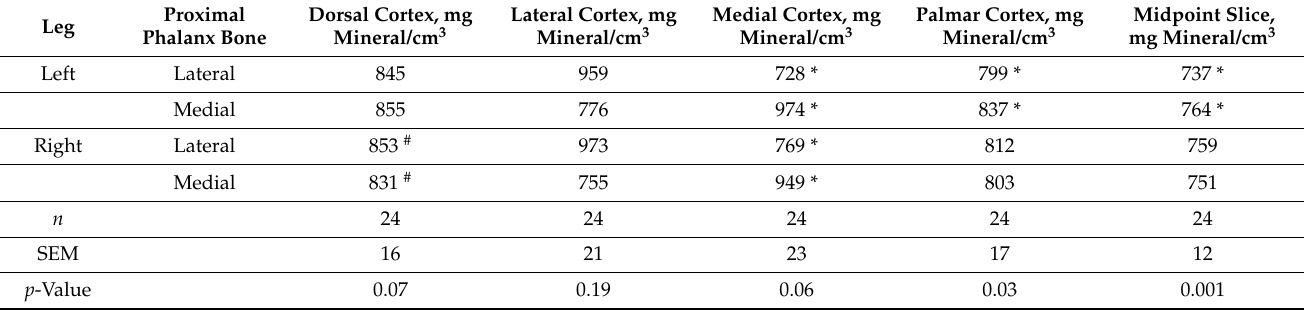
Table 5. Cortical bone mineral density of the lateral and medial proximal phalanx of left and right legs.